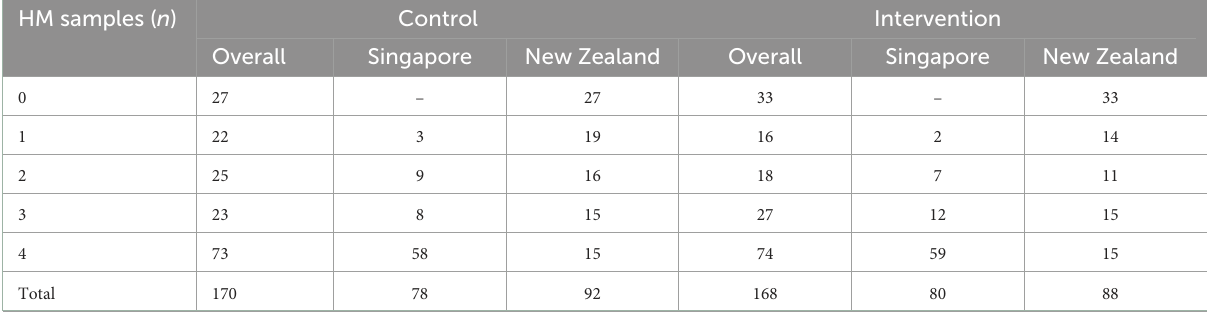
TABLE 2 Number of longitudinal human milk (HM) samples collected per participant in the first 3 months of lactation in Singapore and New Zealand. HM samples ( n )